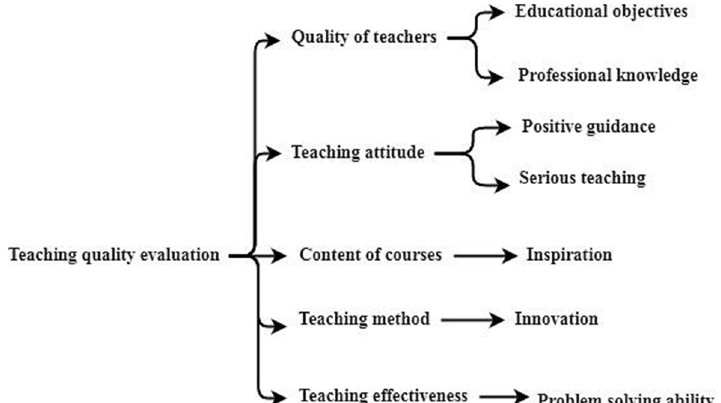
Fig. 2 Overview of teaching quality